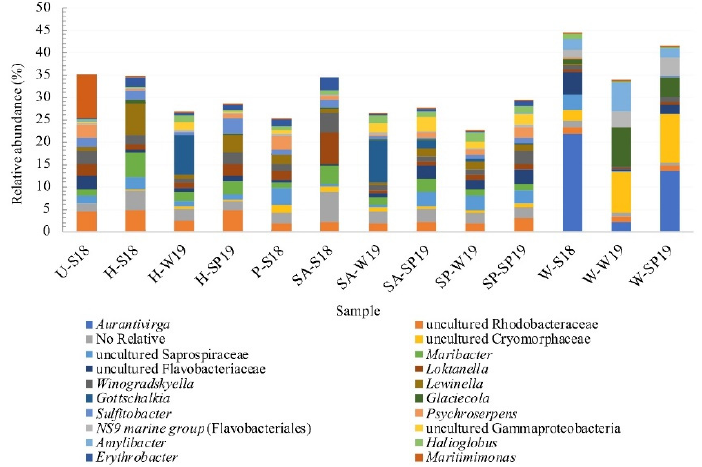
Figure 7. Taxonomic profile of top 20 prokaryotic taxa at lower level (genus) in each type of samples (biofouling from the floating platform, biofilm from the planting media and water). Top 20 represents 33% of the total sequences dataset. Codes: biofouling samples from the floating platform (H = non-planted holes and U = under surface); biofilm samples from the planting media (SP = Spartina maritima ; SA = Sarcocornia perennis ; and P = Phragmites australis ) and water samples (W); S18 = Summer of 2018; W19 = Winter of 2019 and SP19 = Spring of 2019.